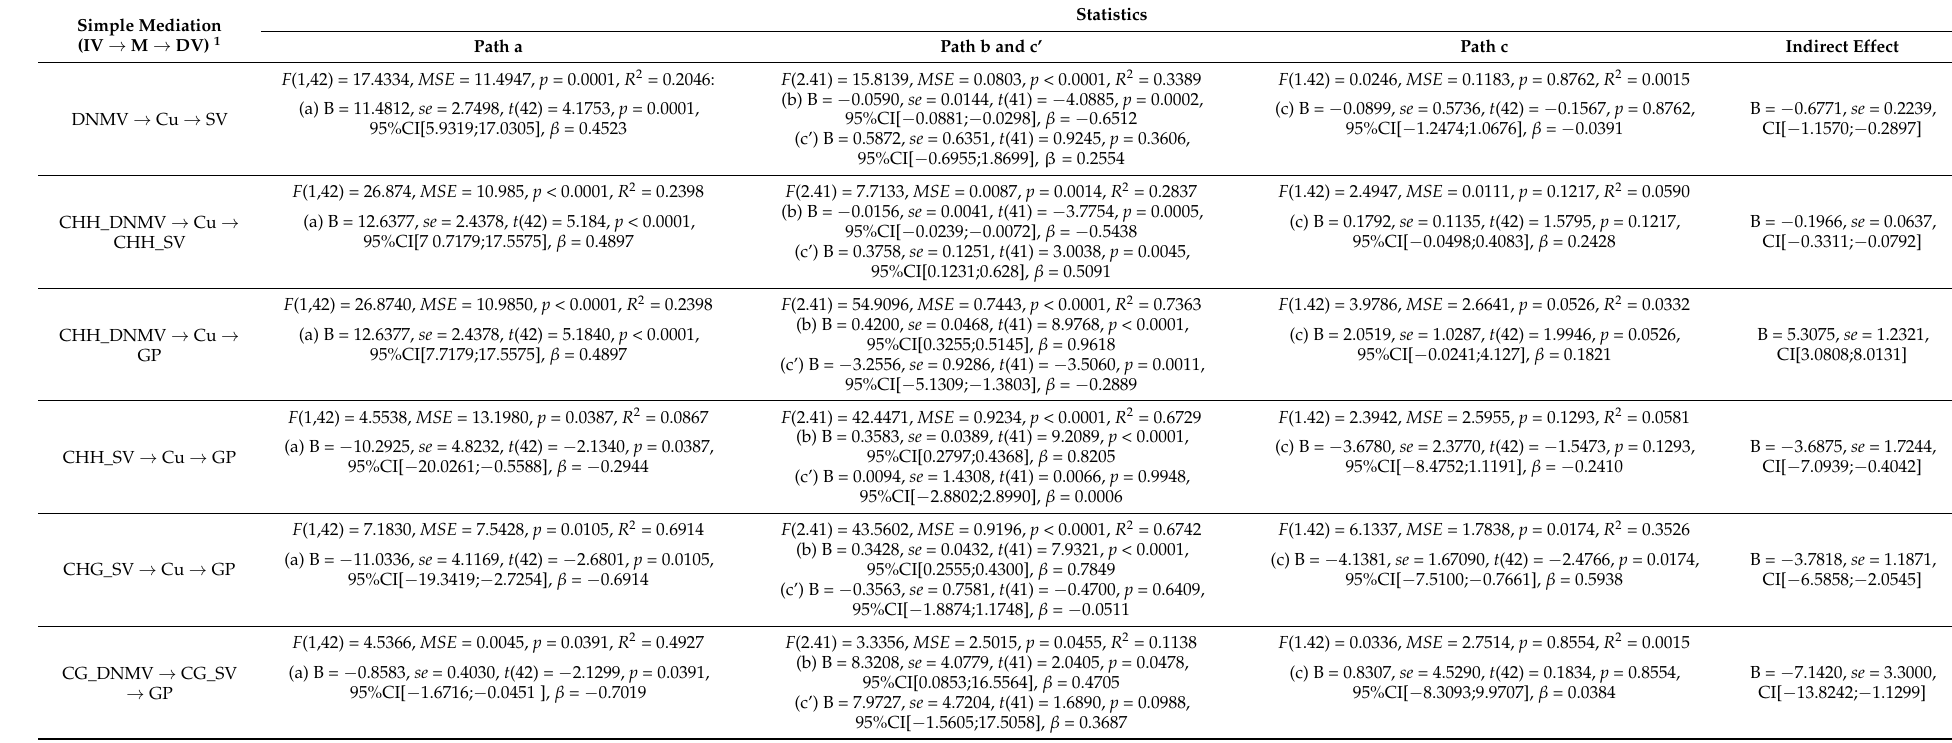
Table 2. Mediation analyses outcomes depicting relationships between DNMV (CHH_DNMV) and SV (CHH_SV) mediated by copper ions, CHH_SV and CHH_DNMV and GP with copper ions as a mediator and CG_DNMV and GP mediated by CG_SV. Both unstandardized (B) and standardized ( β ) coefficients are